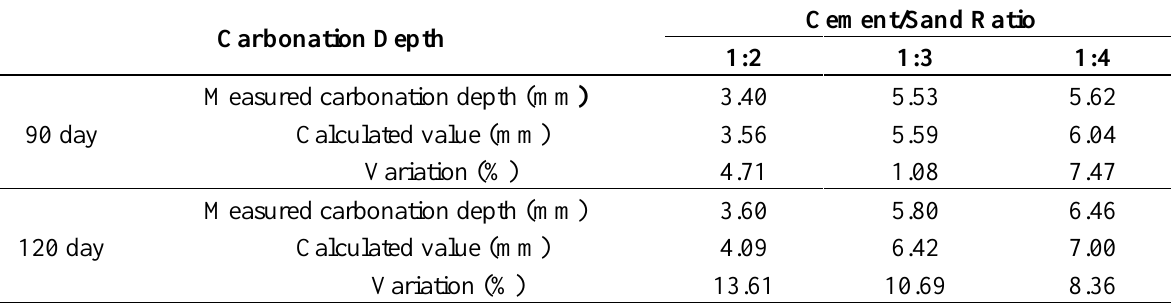
Table 3. The comparison of average measured carbonation depth for mortars with different cement/sand